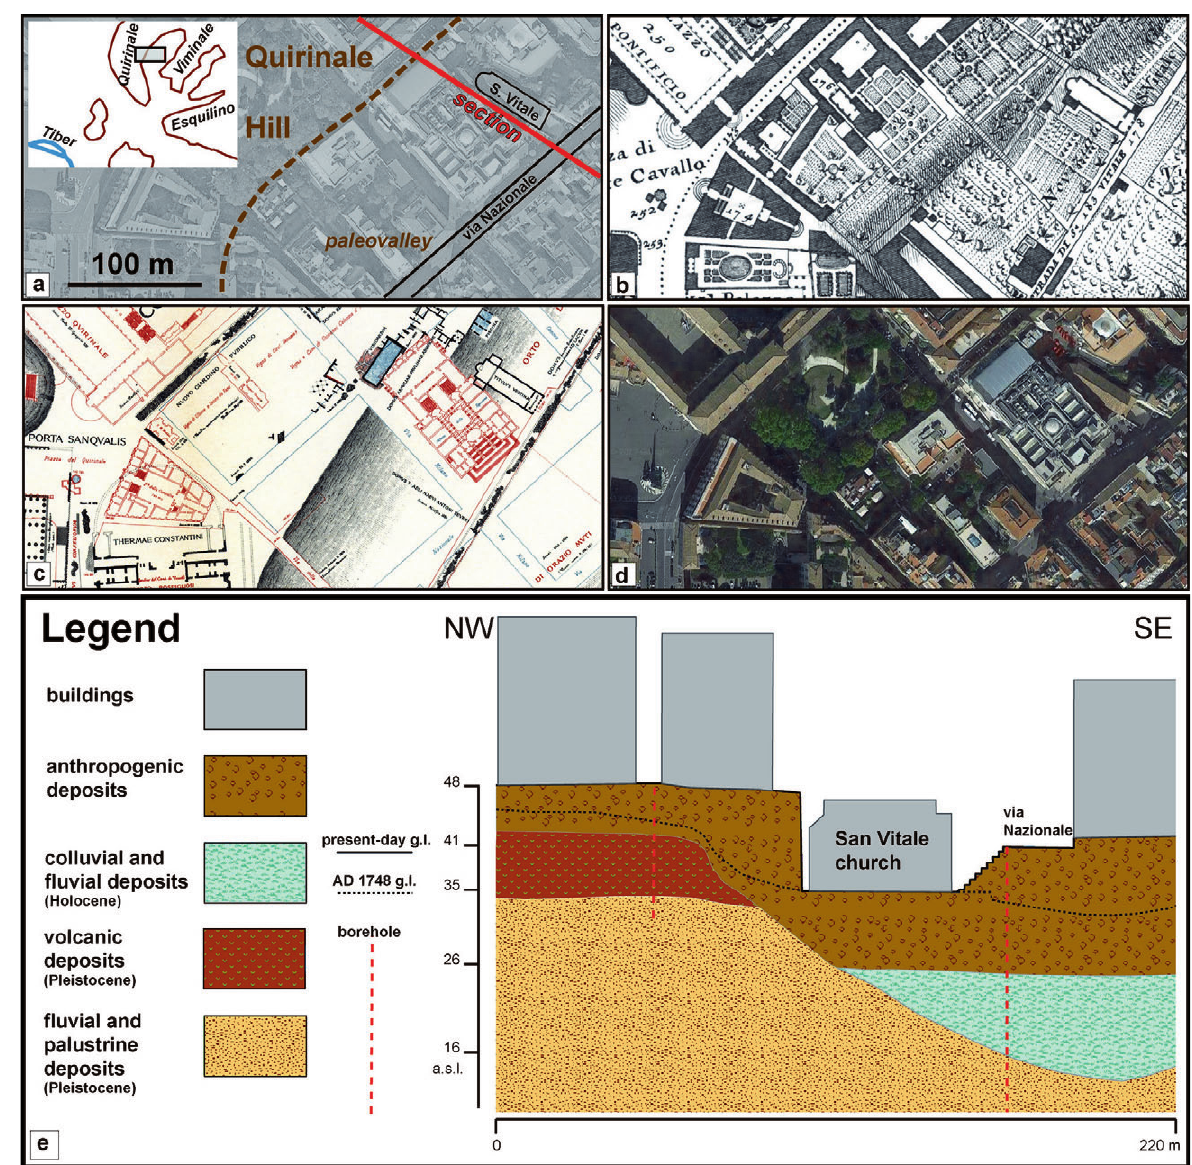
Fig. 4. Evolution of the landscape of the San Vitale church